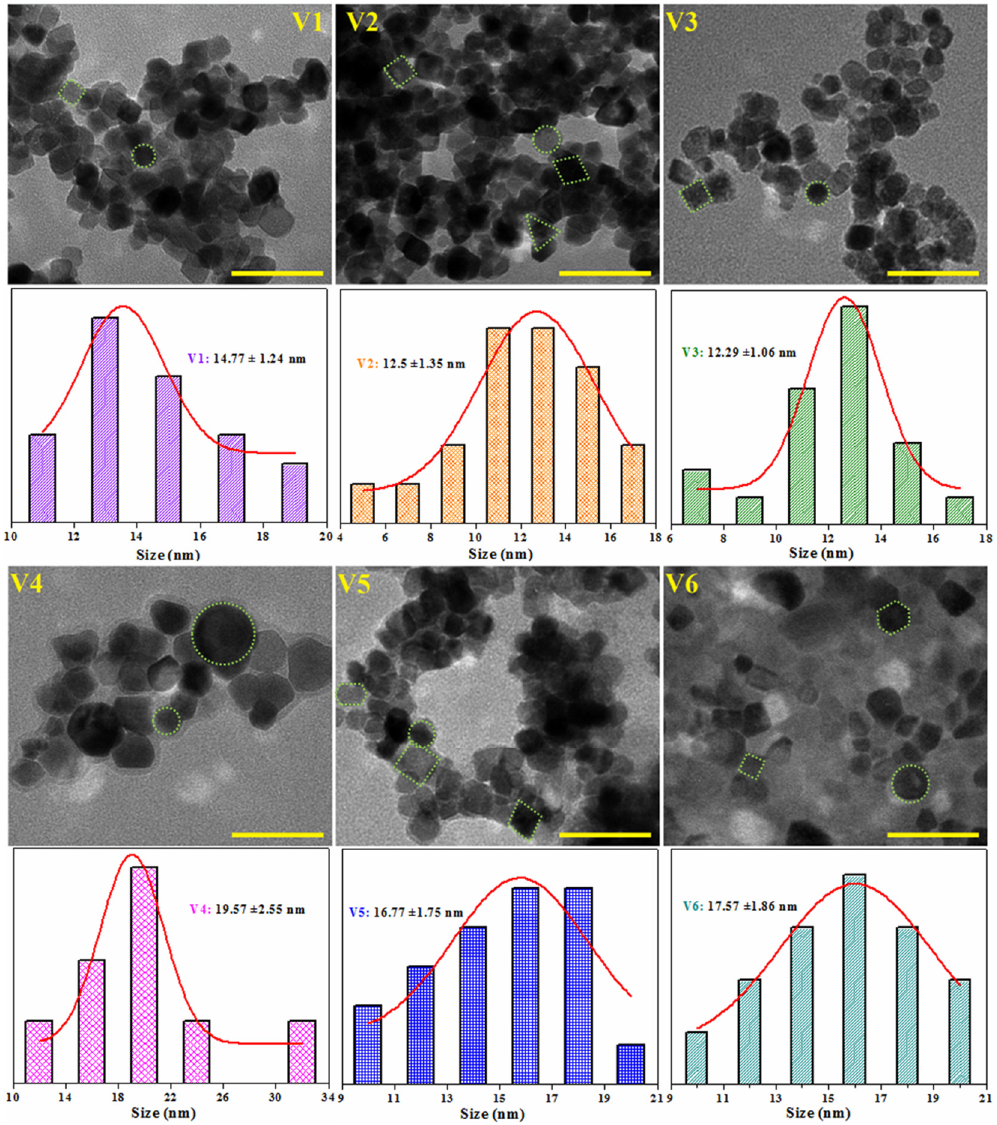
Figure 4. TEM images of CeO 2 nanoparticles and the corresponding particle size distribution. Scale bar is 50 nm.